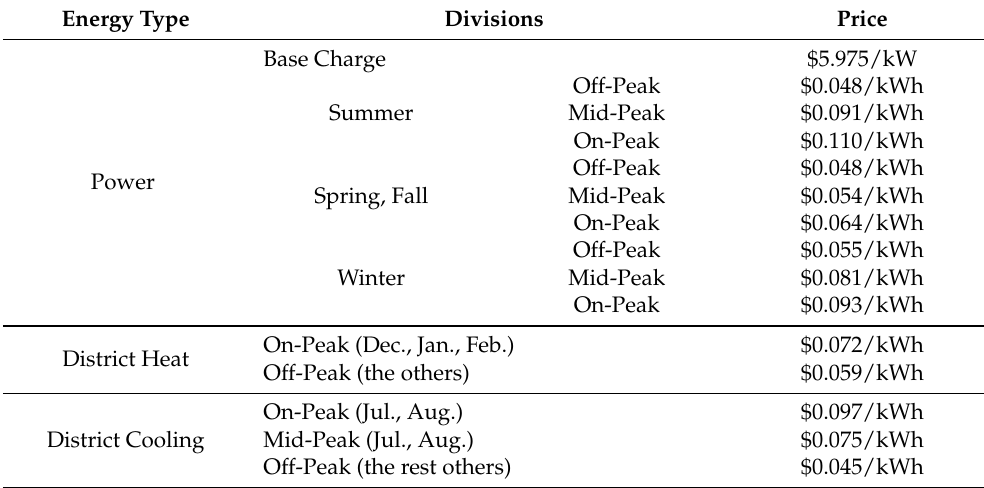
Table 8. The energy charging plans with external suppliers for district heat and power.